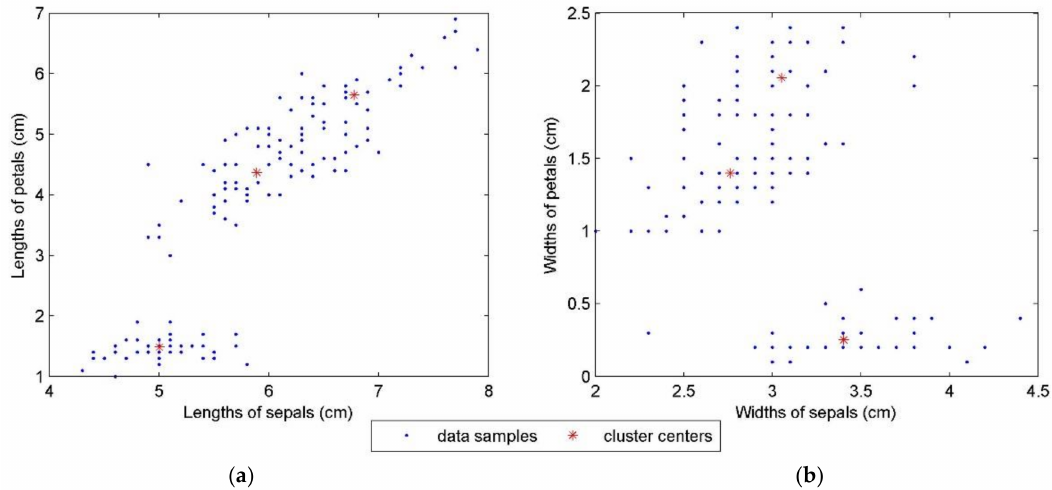
Figure 5. The optimized cluster centers of IRIS data sets. ( a ) Length of petals-length of sepals plane; ( b ) Width of petals-width of sepals